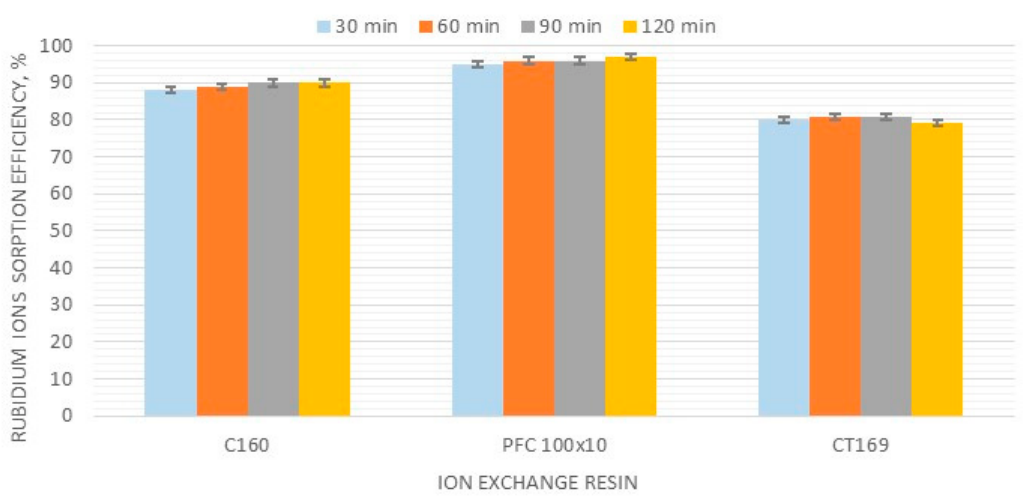
Figure 2. Effect of contact time on the rubidium ion sorption efficiency.